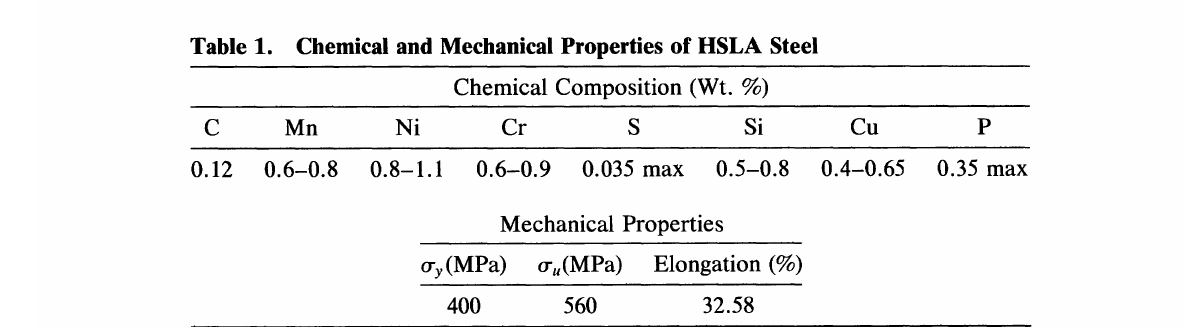
Table 1. Chemical and Mechanical Properties of HSLA Steel Chemical Composition (Wt.